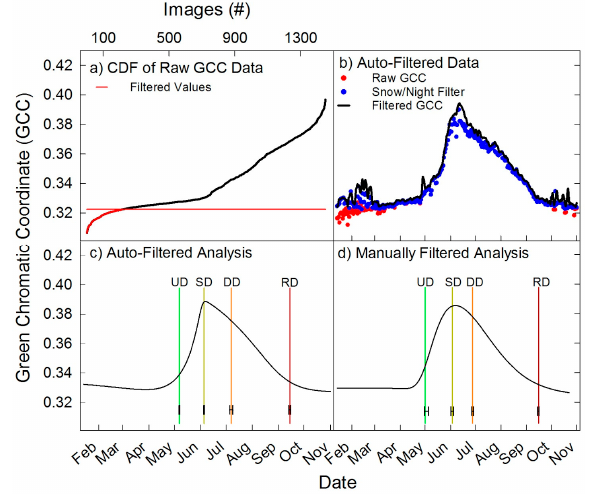
Figure 3. Analyses of the wet meadow to demonstrate snow/night filter. ( a ) Cumulative distribution frequency of GCC for all images, with the red line being the first break in slope and data below this was removed with snow/night filter; ( b ) raw data (red dots) with snow/night filter shown as blue dots, and black line is with the max filter applied; ( c ) Fitted and threshold seasonal GCC values obtained with the snow/night filter; ( d ) Fitted and threshold seasonal GCC values obtained on manually filtered images.